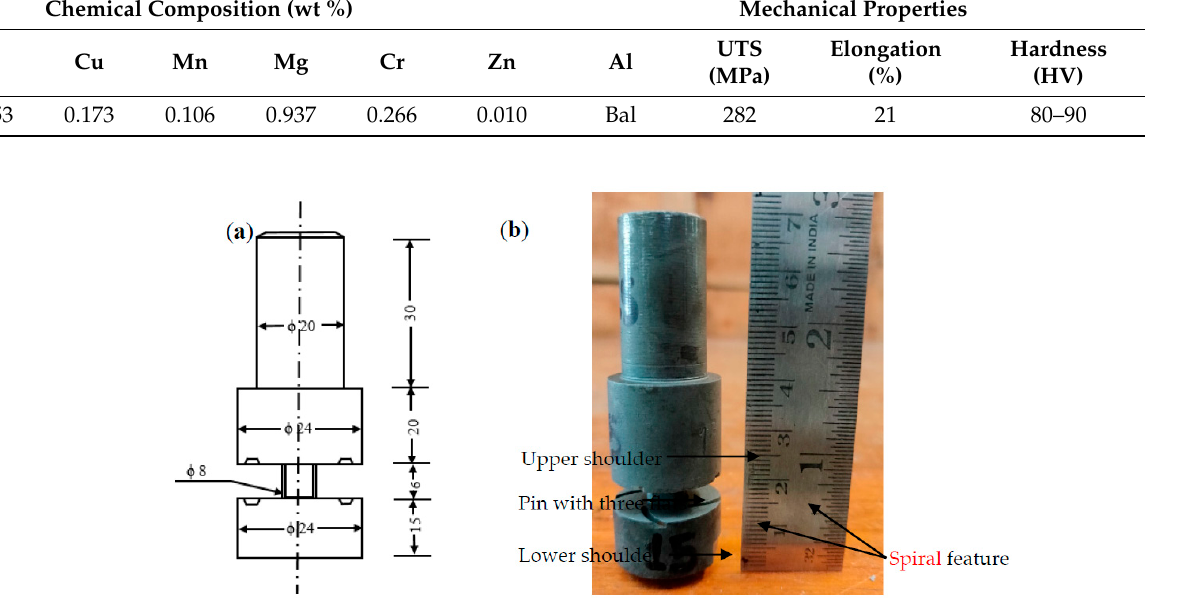
. Figure 2. ( a ) Experimental set-up, ( b – d ) schematic of NAC, S-RM and S-IM, and C-RJ cooling assisted approach respectively.